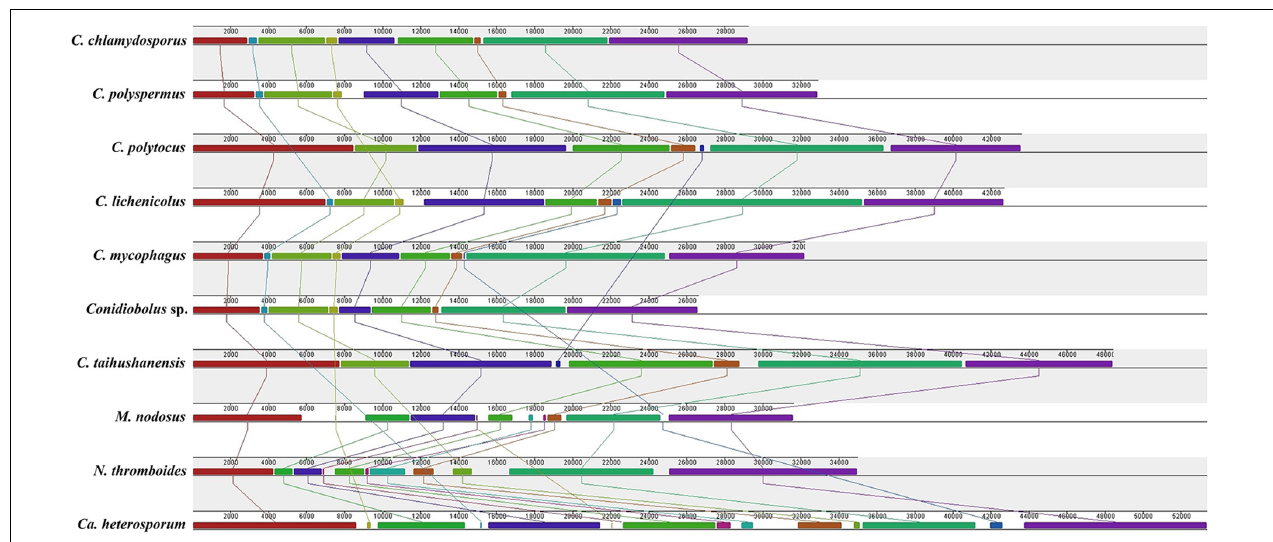
FIGURE 5 | Synteny comparison of mitogenomes among six Conidiobolus s.s. and four related species.